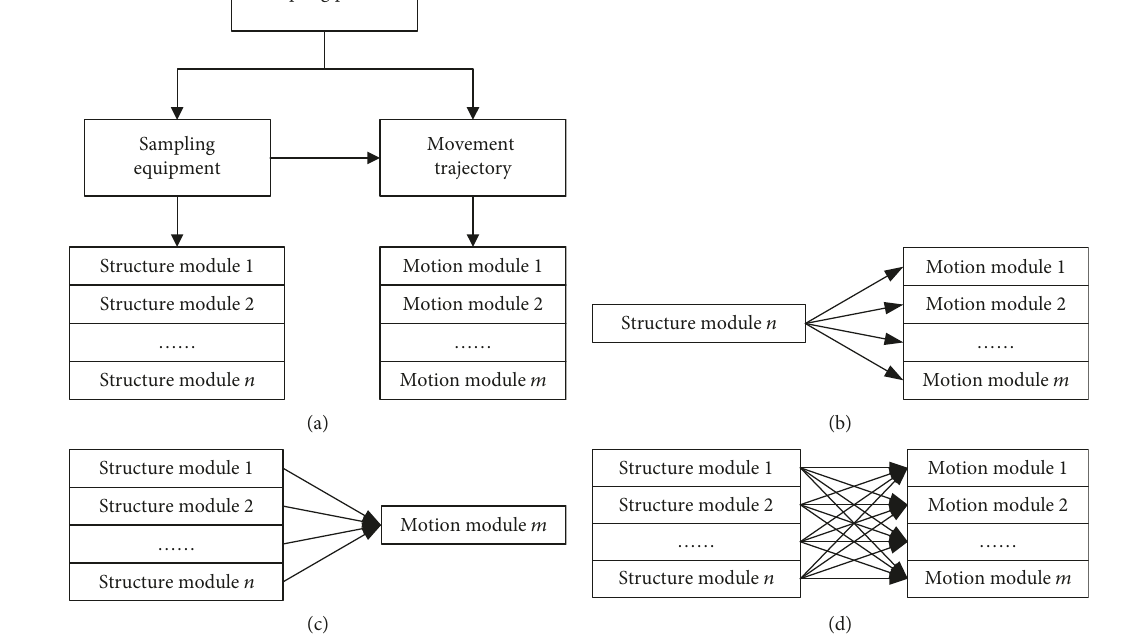
Figure 14: Principle of coupling analysis for the motion and structure groups.